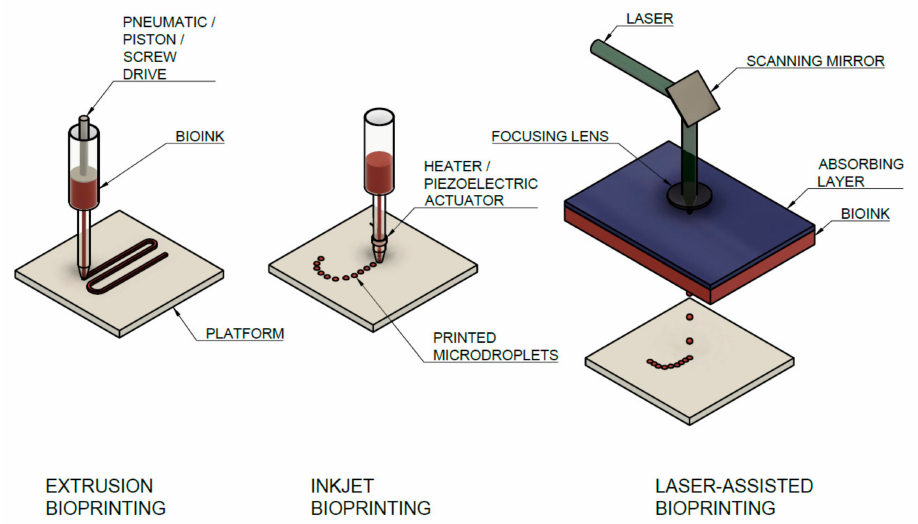
Figure 7. Main additive manufacturing technologies for collagen bioprinting with a description of the main parts of the